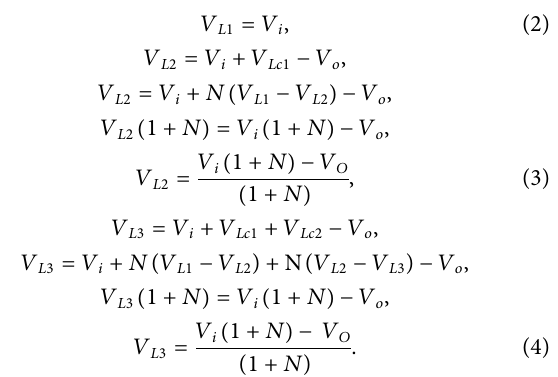
Mode 1: as shown in Figure 3A , switch S1 is initially turned on, while switches S 2 and S 3 are turned off. Current from the battery fl ows through the winding L 1 and switch S 1 . The battery current also conducts L 2 and L 3 . Current fl ows through L 2 to D 2 , L C1 , D 4 , C, and the load. Current fl ows through L 3 to D 3 , L C2 , L C1 , D 4 , C, and the load. The voltage equation is given as